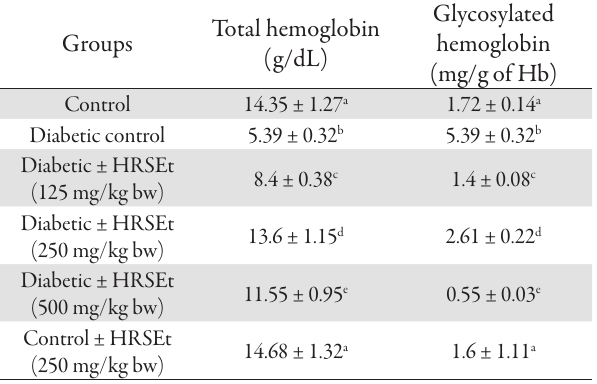
Tab. 3. Effect of HRSEt on the levels of glucose-6-phosphatase